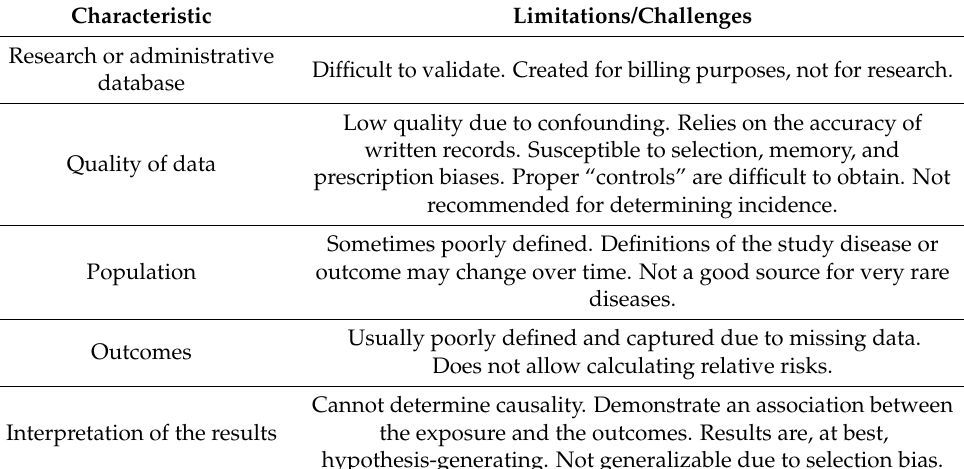
Table 1. Challenges and limitations of retrospective